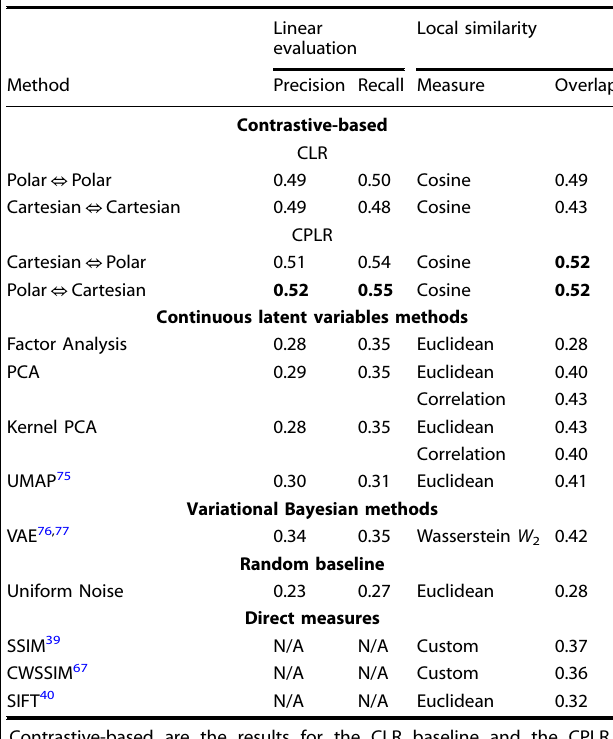
Table 1. Macroaverage results (see section 13.6 in ref. 68 .) on the helium nanodroplets